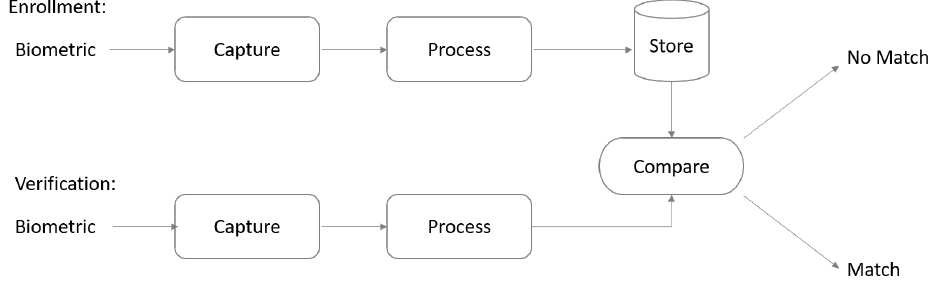
Figure 1. Biometric enrolment and verification